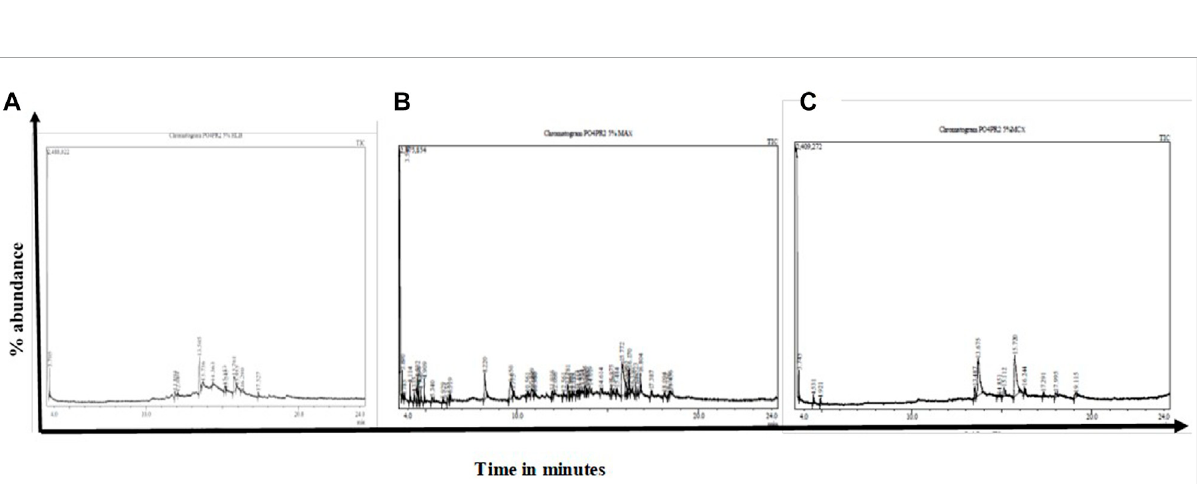
FIGURE 5 GC-MS chromatographs of the endophytic fungi fractions from A. alternata (PO4PR2) (A – C) showed indicate chromatographs of the (A) HLB cartridges fractions; (B) MCX cartridge (C) , MAX. The fractions were eluted from the different cartridges using 5% methanol. PO4PR2 was isolated from Hypoxis species root and has high selective index.